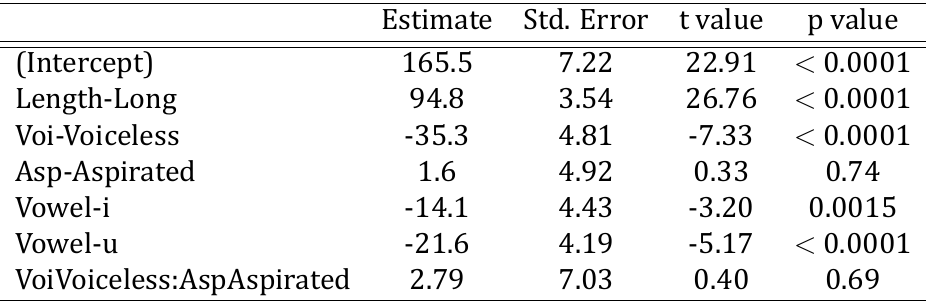
Table 2: Mixed effects model for phonological predictors of Hindi vowel duration. Inter- cept: Length = Short; Voicing = Voiced; Aspiration = Unaspirated; Vowel = /a/